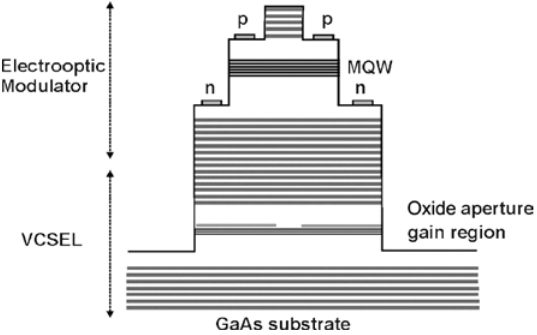
Figure 1: Schematic representation of the experimentally fabricated EOM